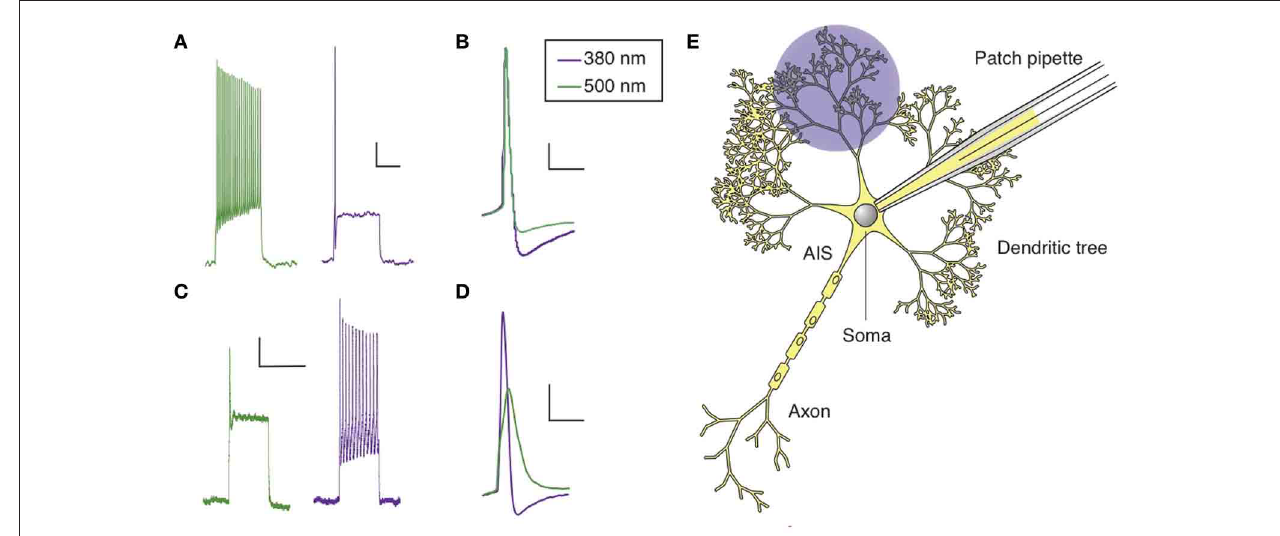
the patch pipette, showing the effect of light on spike inhibition. (D) AP shape in both wavelength of light for a neuron loaded with QAQ. (E) Patterned illumination for the optical control of the excitability of a dendritic tree using QAQ loaded through the patch pipette. The main regions of a neuron are indicated. Scale bars (A,C) 10mV, 500ms; (B,D) 10mV,